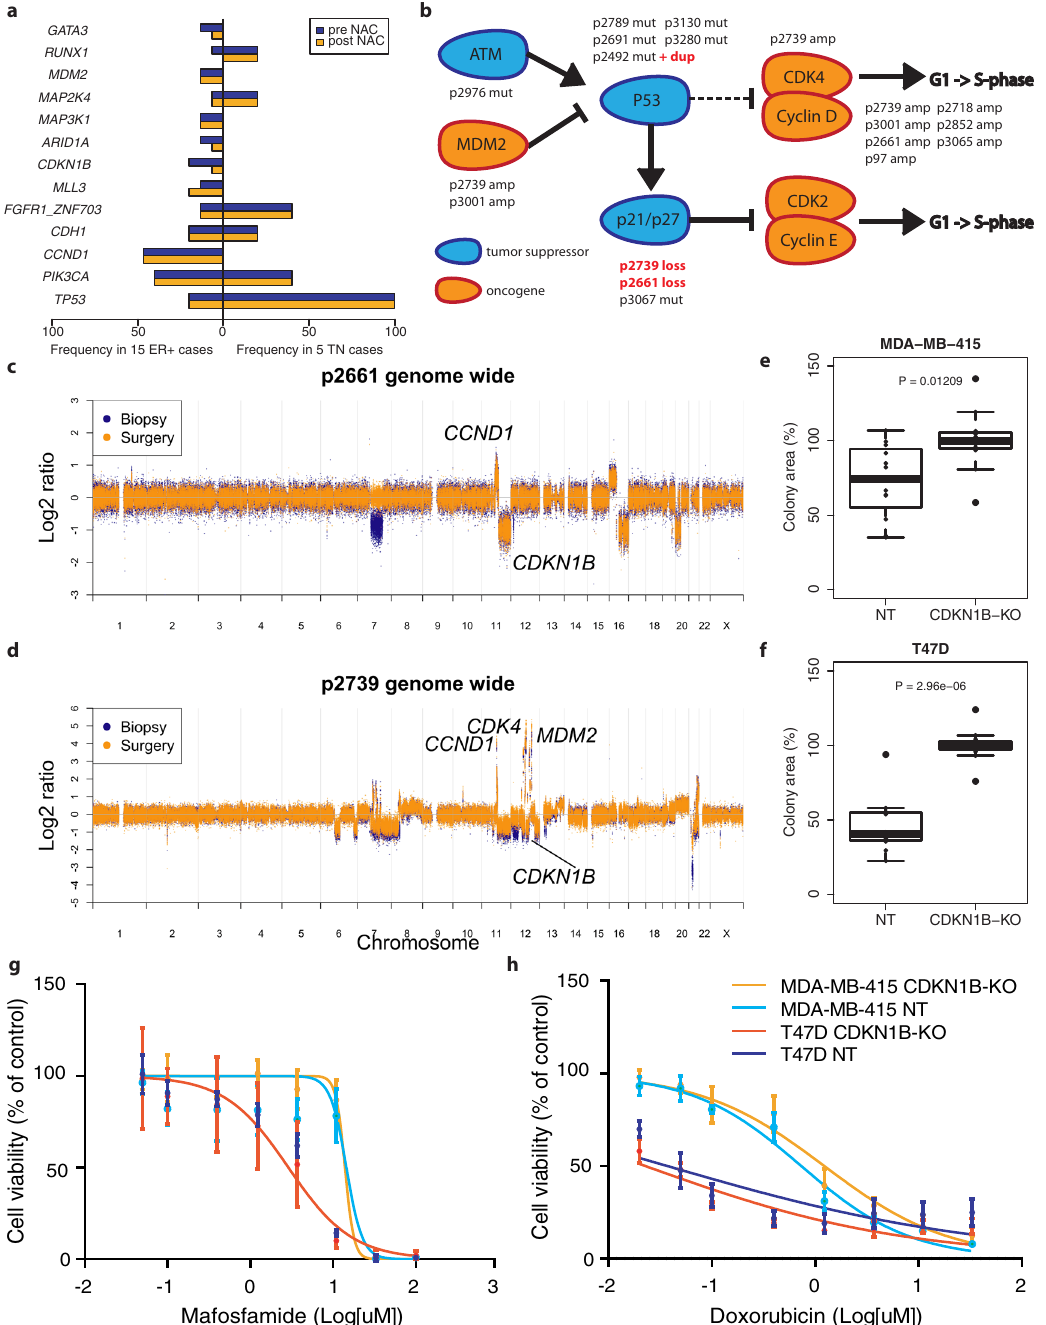
Fig. 3 Genomic differences between breast tumors before and after chemotherapy. a Barplot of genes frequently aberrated in our cohort. Copy number changes and mutations are combined. In blue: frequency before treatment; orange: frequency after treatment. NAC neoadjuvant chemotherapy. b Simpli fi ed version of the cell cycle checkpoint pathway, highlighting genes aberrated in our cohort. Tumor suppressor genes are shown in blue, oncogenes in orange. Aberrated samples are indicated above/below the genes. Sample names in red indicate that the genetic aberration was not shared between the pre- and post-treatment sample. c Genome-wide copy number plot of patient s2661. Copy number changes of genes included in b are labeled. In blue, the copy number data of the pre-treatment sample; in orange, the post-treatment sample. d Genome-wide copy number plot of patient s2739. Layout is identical to ( c ). e Boxplots showing cell growth of MDA-MB-415 ( CCND1 ampli fi ed) breast cancer cell lines, with (left) or without (right) functional CDKN1B . f Boxplots showing cell growth of T47D ( CCND1 neutral) breast cancer cell lines, with (left) or without (right) functional CDKN1B . g Effect of CDKN1B knock-out on mafosfamide sensitivity in T47D ( CCND1 neutral) and MDA-MB-415 ( CCND1 ampli fi ed) breast cancer cell lines. Dark and lightblue: controls, red and orange: CDKN1B knock-out. h Effect of CDKN1B knock-out on doxorubicin sensitivity in T47D ( CCND1 neutral) and MDA-MB-415 ( CCND1 ampli fi ed) breast cancer cell lines. Dark and lightblue: controls, red and orange: CDKN1B knock-out. NT non-targeting control gRNA, KO knock- out with CDKN1B targeting gRNA. For box plots in this fi gure, the boxes indicate the interquartile range, while lower and upper bars correspond to the minimum and maximum non-outlier values of the data distribution. Outliers are de fi ned as values outside 1.5× the interquartile range from the box. The center line indicates the median